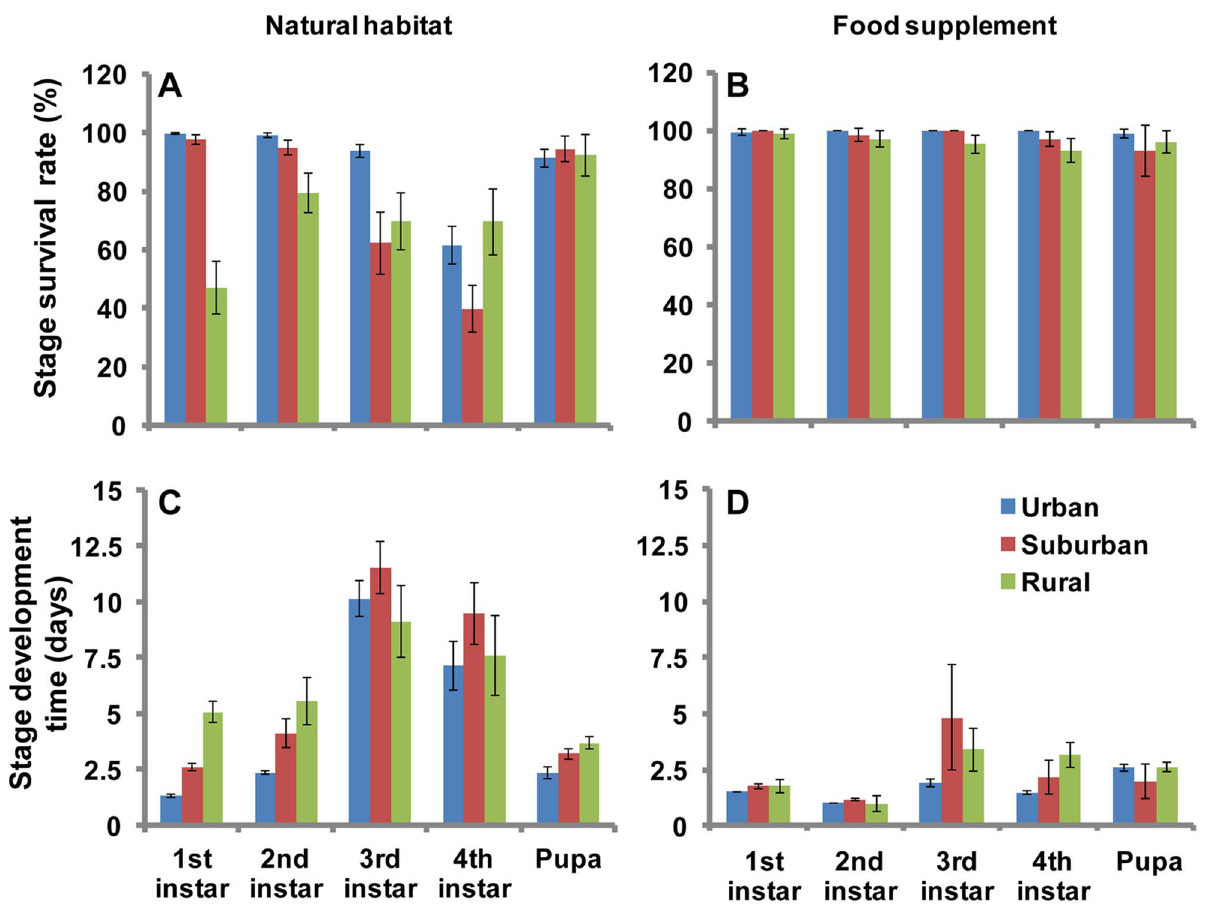
Figure 5. Stage survival rate and stage development time of Aedesalbopictus larvae in urban, suburban and rural areas. A and B: stage survival rate; A: natural habitat; B: food supplement. C and D: stage development time; C: natural habitat; D: food supplement. Values are the mean 6 95%CI.